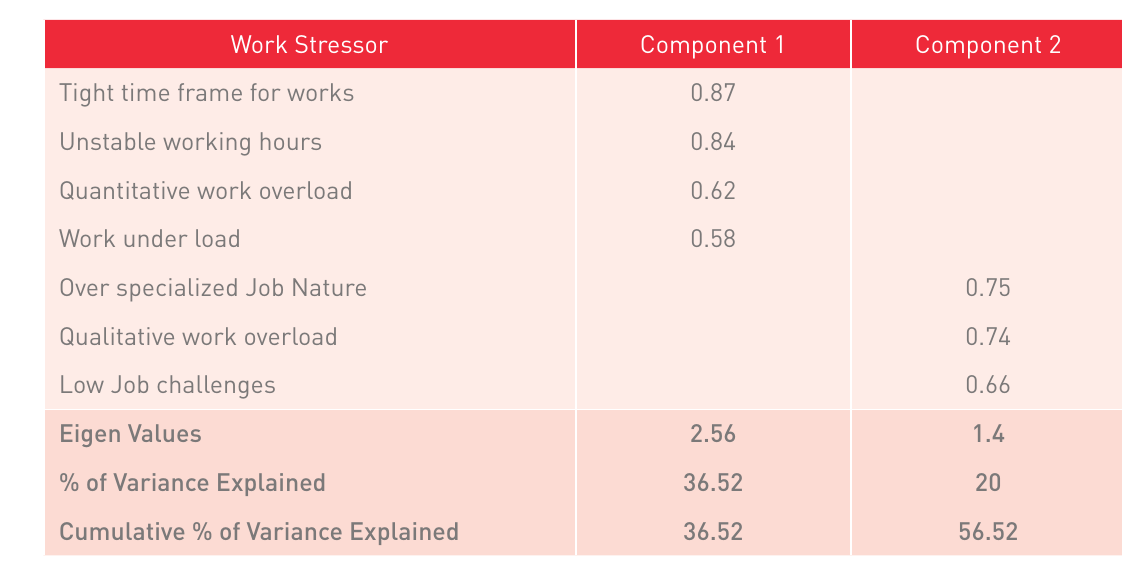
Exploratory Factor Analysis for Work Stressor Scale